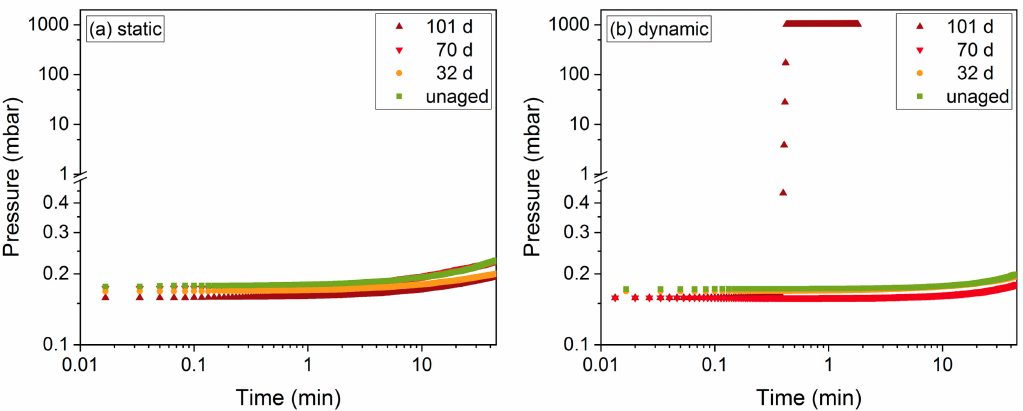
Figure 17. Pressure rise during ( a ) static and ( b ) dynamic leakage test (with partial decompression) of an EPDM seal aged at 150 ◦ C for the respective aging